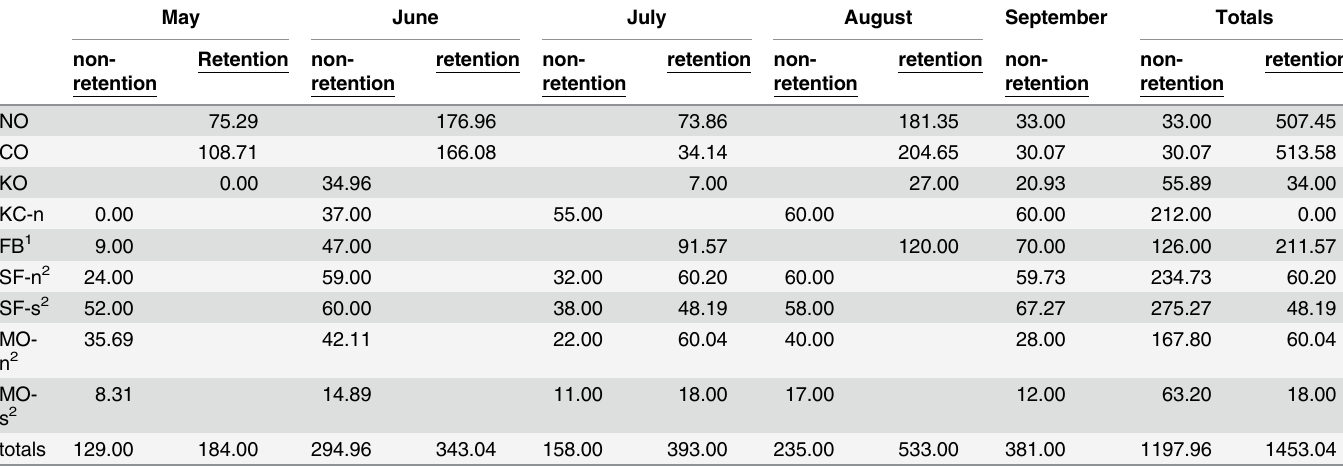
Table 1. Numbers of vessel-days of salmon troll fishing effort for 2010 at-sea sampling across nine spatial strata.